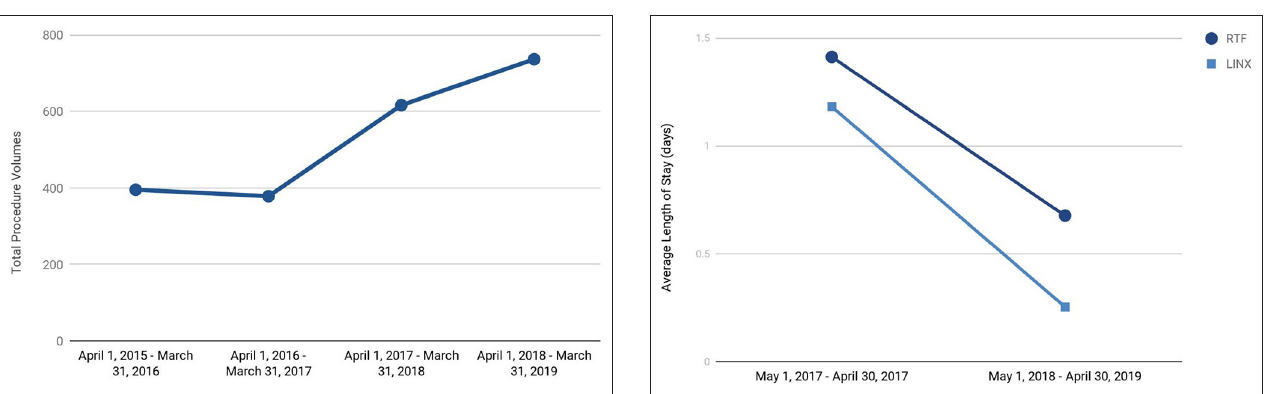
FIGURE 4 | Upward trend in total anti-reflux procedure (pre-surgery diagnostics and surgical) volumes in our heartburn center.